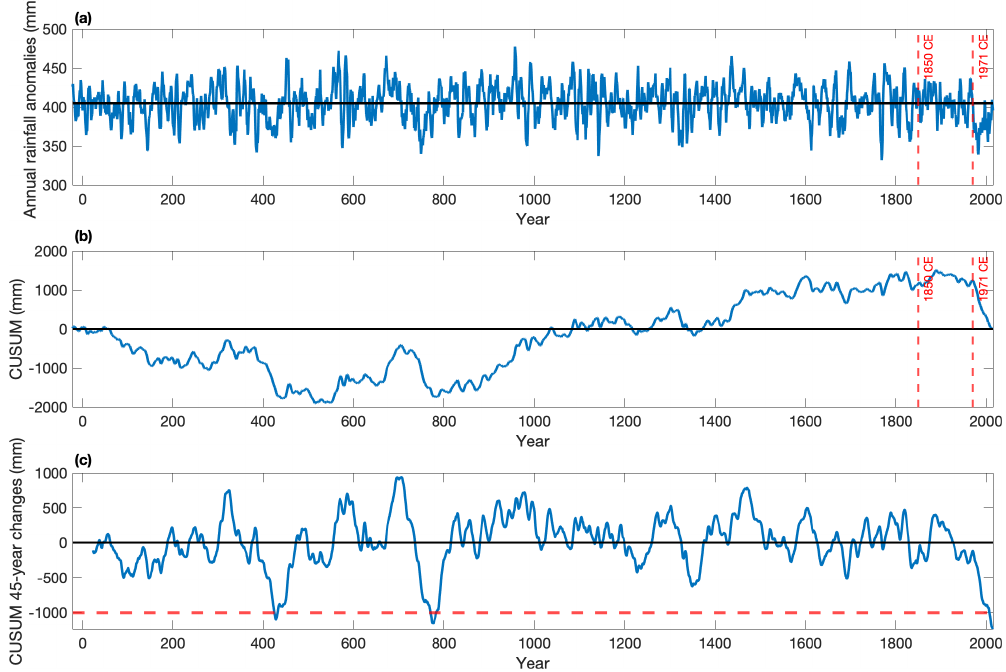
Figure 3. (a) The rainfall reconstruction in the significant region in SWWA (the MASK region; Fig. 1) from 22BCE to 2015CE. The mean of this 2038-year time series (405mmyr − 1 ) is shown as a black horizontal line. (b) The CUSUM rainfall reconstruction (Eq. 3). The black horizontal line represents zero. The red vertical dashed lines highlight the years 1850 and 1971CE. (c) The 45-year running change in the CUSUM rainfall reconstruction series. The red horizontal dashed line represents − 1000mm (accumulated change).